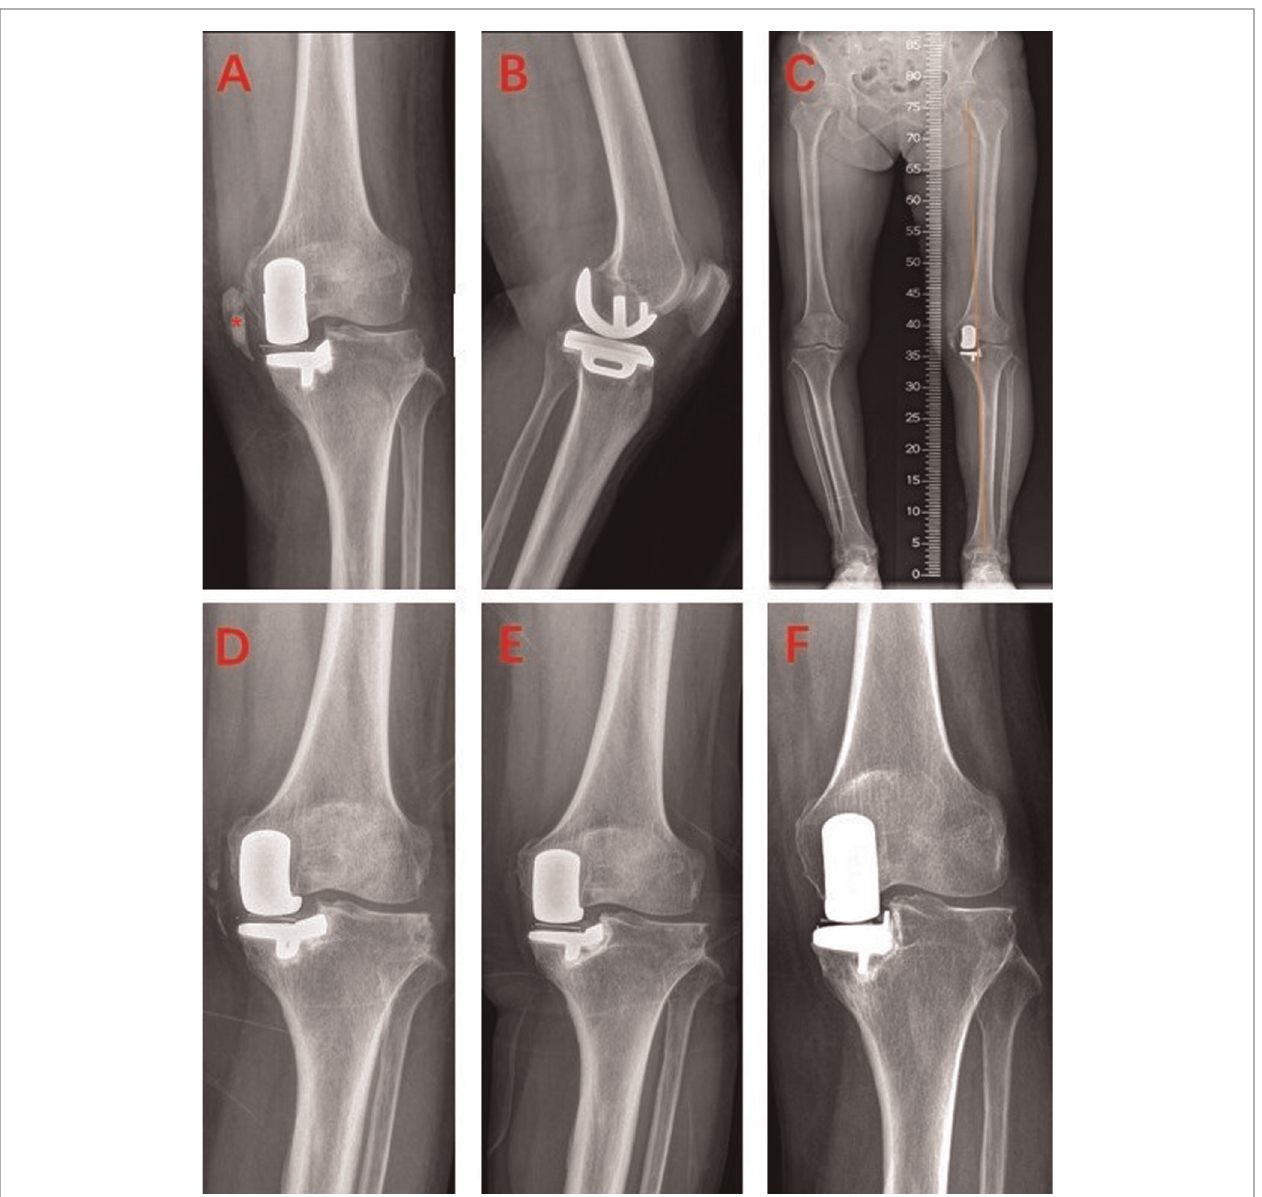
FIGURE 4 | Postoperative x-ray during discharge and follow-up. ( A – C ) X-ray at discharge, *Pellegrini – Stieda lesion; ( D ) postoperative 3 months; ( E ) postoperative 9 months; ( F ) postoperative 3.5